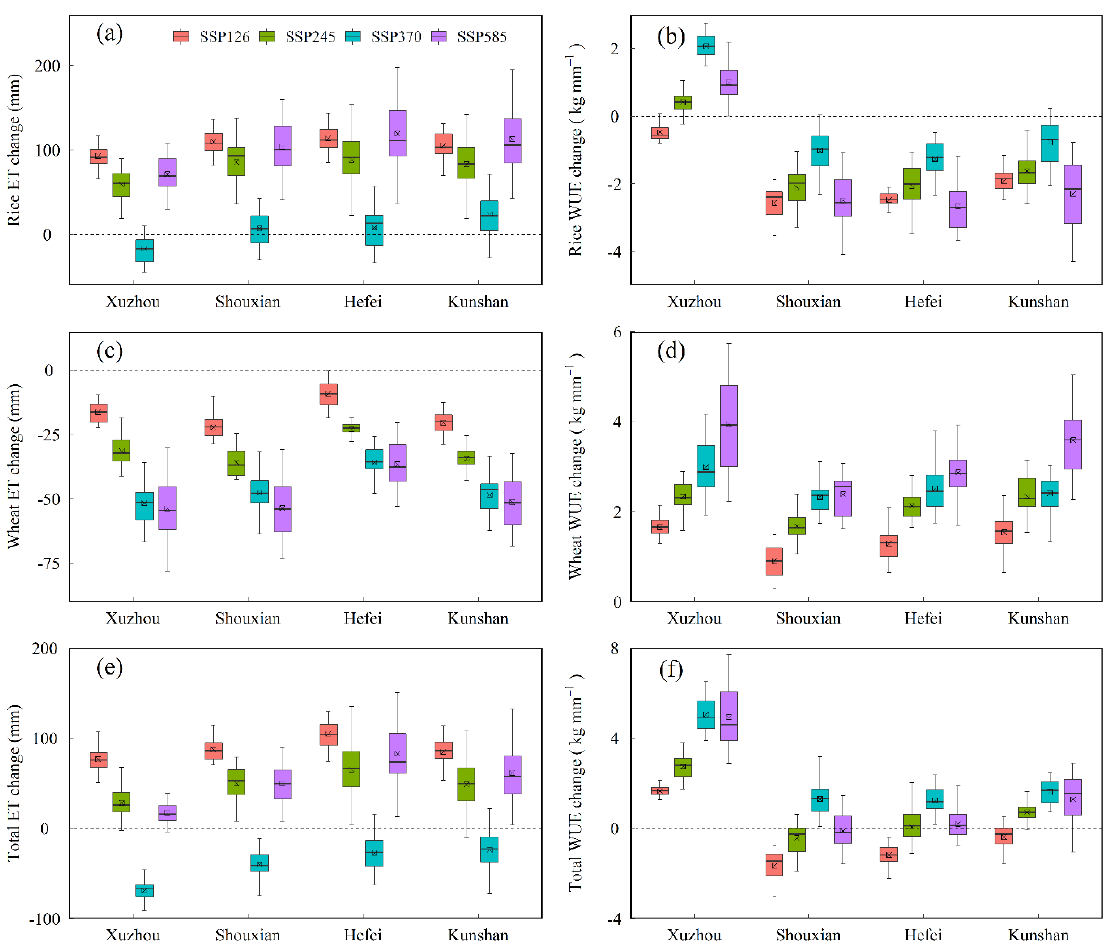
Figure 6. Projected changes in ET ( a , c , e ) and WUE ( b , d , f ) for rice ( a , b ), wheat ( c , d ) and total of rice and wheat ( e , f ) in the 2050s (2041 – 2070) period under SSP126, SSP245, SSP370 and SSP585 compared to the baseline period (1981 – 2010) across the 22 CMIP6 GCMs in the four agro-meteorological stations.